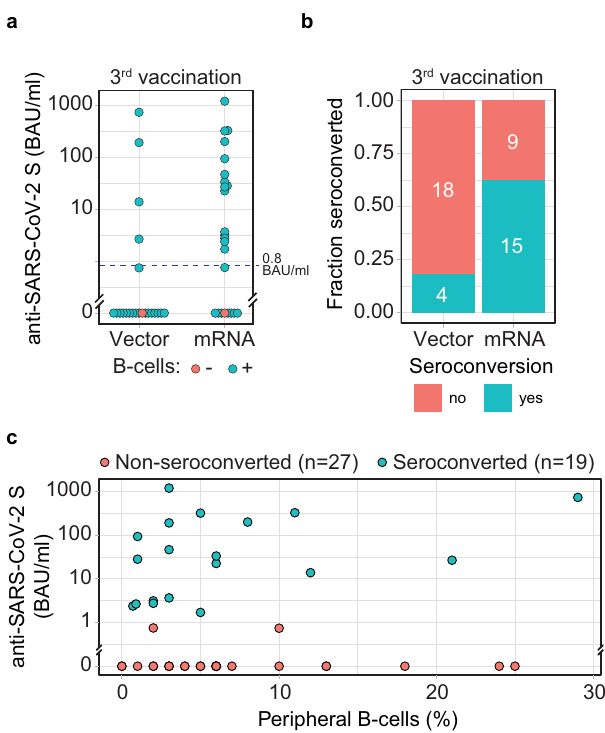
Fig. 2 | Antibody seroconversion 4 weeks after vector vs. mRNA booster vac- cination. Antibodies to the receptor-binding domain (RBD) of the viral spike (S) protein were determined using an anti-SARS-CoV-2 immunoassay 4 weeks after vaccination. a Anti-RBDantibody levels inpatientswith( n =44)and without( n =2) peripheralB-cells,asindicatedby the colorof thecircles.Dashedline indicatesthe threshold for seroconversion (0.8 BAU/ml). b Seroconversion rate was calculated based on the presence of anti-RBD antibodies in patients strati fi ed by booster vaccination with vector or mRNA vaccine. c Anti-RBD antibody levels in patients 4 weeks after booster vaccination were correlated with levels of detectable per- ipheral CD19 + B-cells, with the color of the circles indicating status of seroconver- sion. Source data are provided as a Source Data fi le.